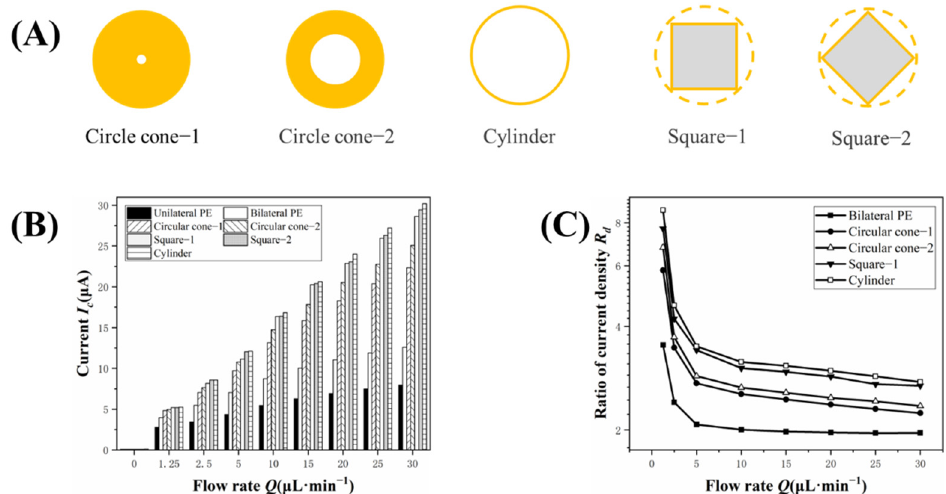
Figure 6. ( A ) Cross-section of the micropillars in different shapes with the same base radius (50 µm). ( B ) Current responses of the PE, the bilateral PE and bilateral µAEs in different shapes under vary- ing flow rates; ( C ) The current density ratios of these µAEs in different shapes under varying flow